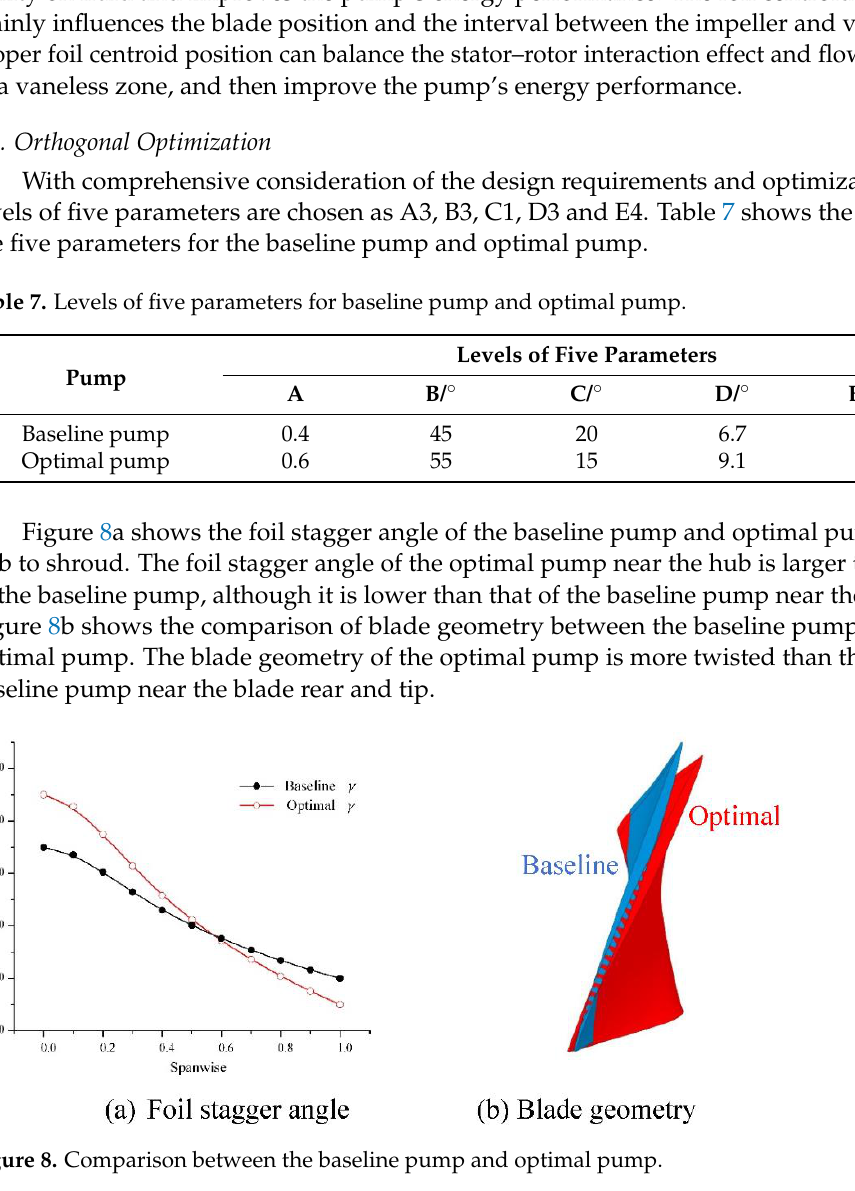
Figure 9. Performance of baseline pump and optimal pump.